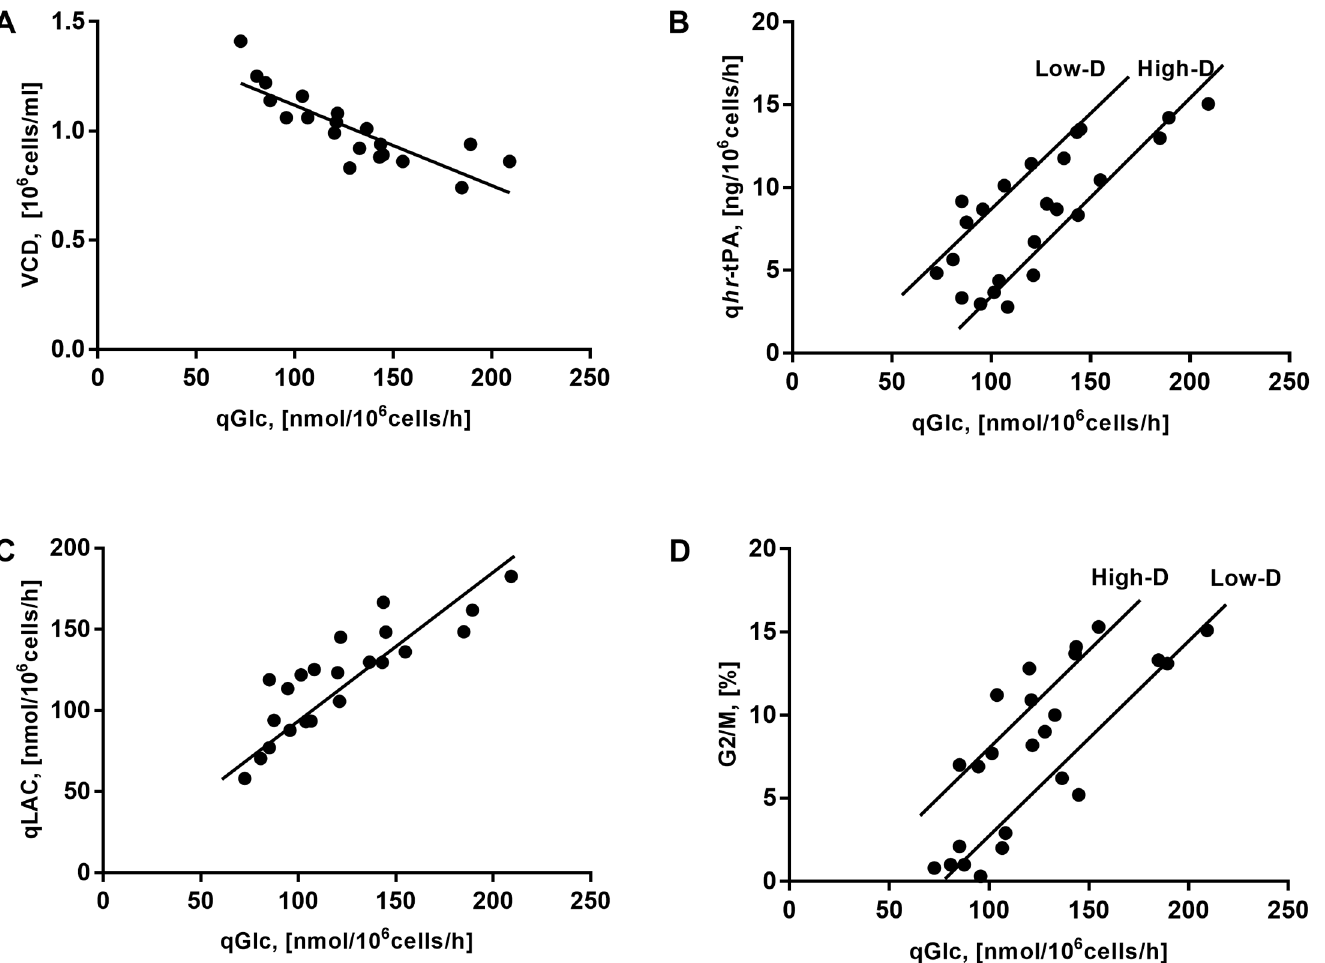
Fig 5. Correlation of physiological parameters and q GLC observed by PCA in CHO cells cultures at different glucose concentrations, dilution rates and culture temperatures. A corresponds to the correlation between viable cell concentration and q GLC (Pearson’s correlation R = -0.83, p < 0.05). B corresponds to the correlation between q rh -tPA and q GLC (Pearson’s correlation R = 0.94, p < 0.05 for High-D, and R = 0.91, p < 0.05 for Low-D). C corresponds to the correlation between q LAC and q GLC (Pearson’s correlation R = 0.74, p < 0.05). D corresponds to the correlation between G2/M and q GLC (Pearson’s correlation R = 0.81, p < 0.05 for High-D, and R = 0.98, p < 0.05 for Low-D). The pearson correlation coefficients were calculated using the R software